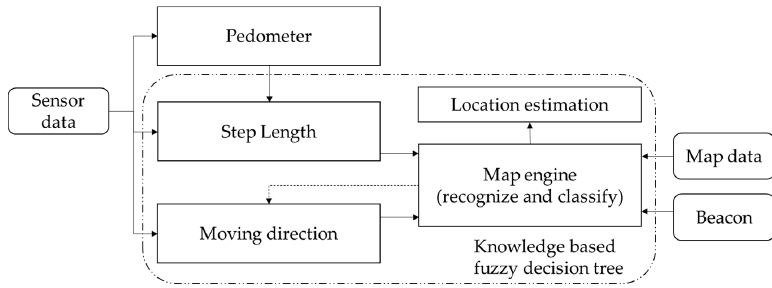
Figure 6. The architecture of the proposed system, with fuzzy decision tree.